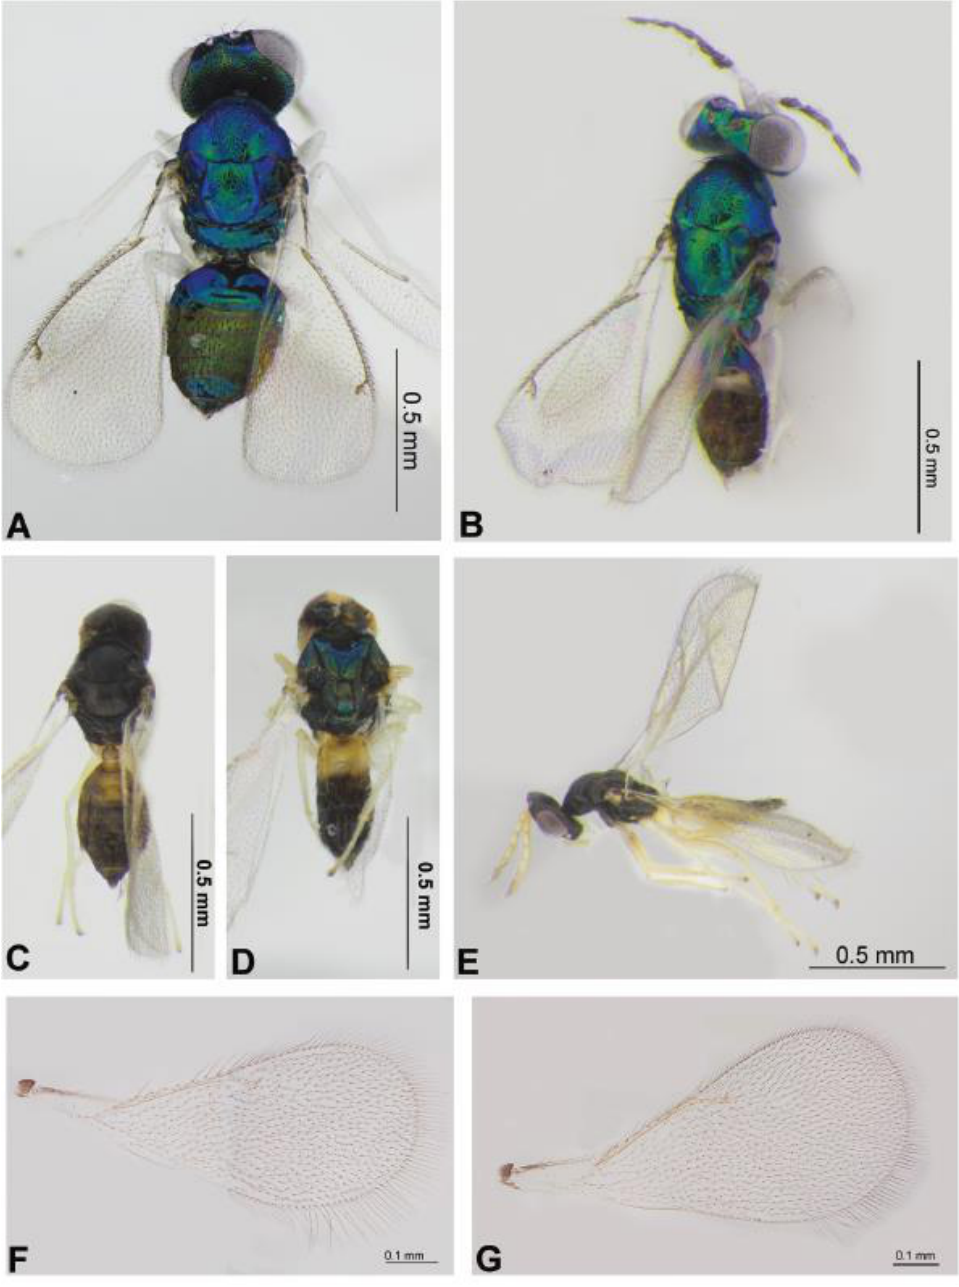
Figure 7. Entedoninae and Tetrastichinae: Achrysocharoides cilla (Walker, 1839) (female and male) ( A , B ), Mischotetrastichus petiolatus (Erdös, 1961) ( C , E , G ), Minotetrastichus frontalis (Nees, 1834) ( D ) and Mischotetrastichus nadezhdae (Kostjukov, 1977) ( F ). Habitus in dorsal view ( A – D ) and lateral view ( E ), fore wing ( G , F ).